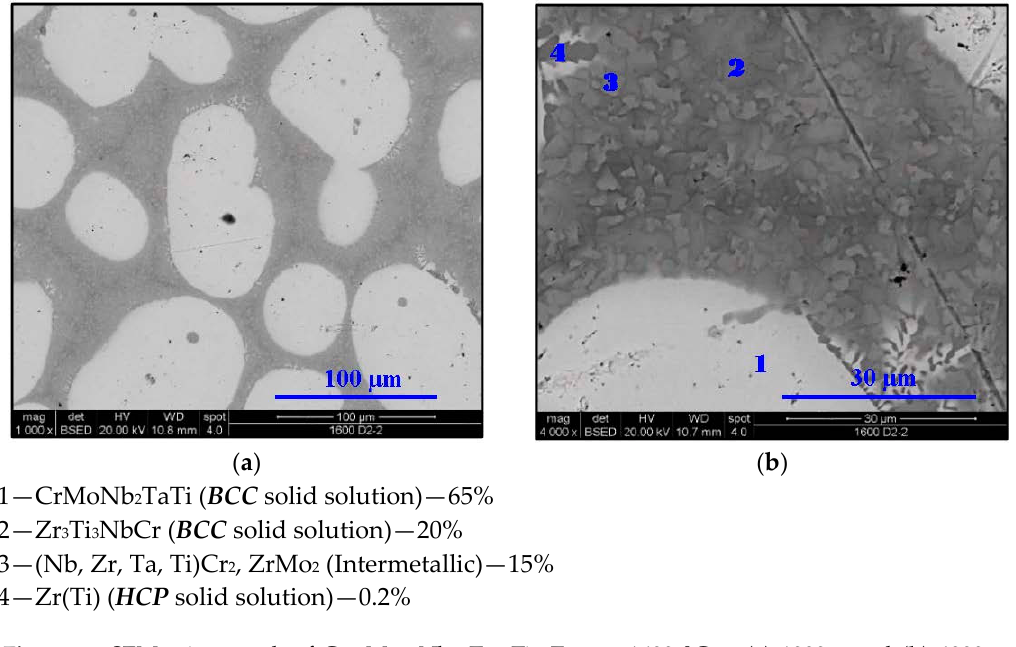
Figure 7 . SEM micrograph of Cr 20 Mo 10 Nb 20 Ta 10 Ti 20 Zr 20 at 1600 °C at ( a ) 1000× and ( b ) 4000× magnifications Figure 7. SEM micrograph of Cr 20 Mo 10 Nb 20 Ta 10 Ti 20 Zr 20 at 1600 ◦ C at ( a ) 1000 × and ( b ) 4000 × in BSE mode. magnifications in BSE mode.